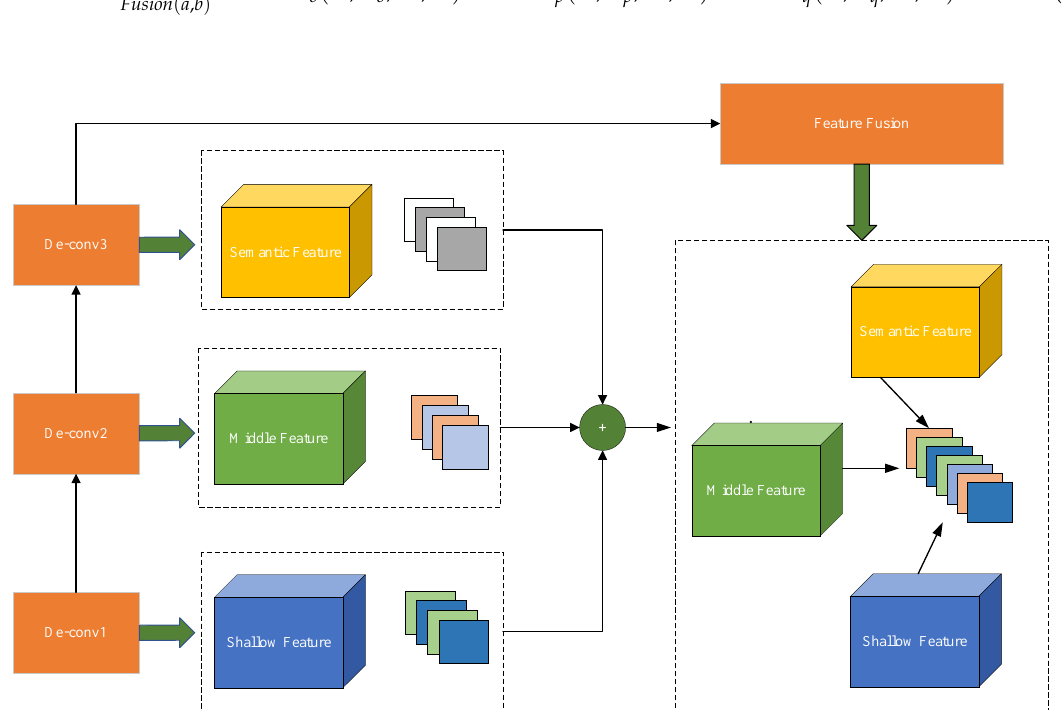
Figure 2. Schematic diagram of the multi-level feature fusion process.